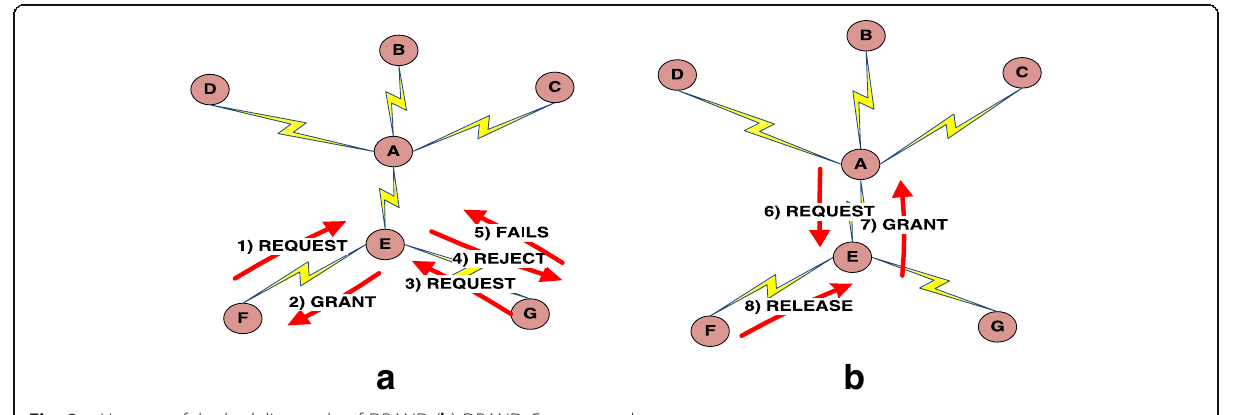
Fig. 2 a Unsuccessful scheduling cycle of DRAND ( b ) DRAND Grant